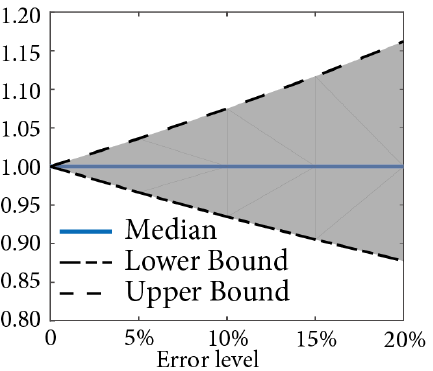
Figure 5. Confidence interval of the estimation for EI 2 under different error levels.